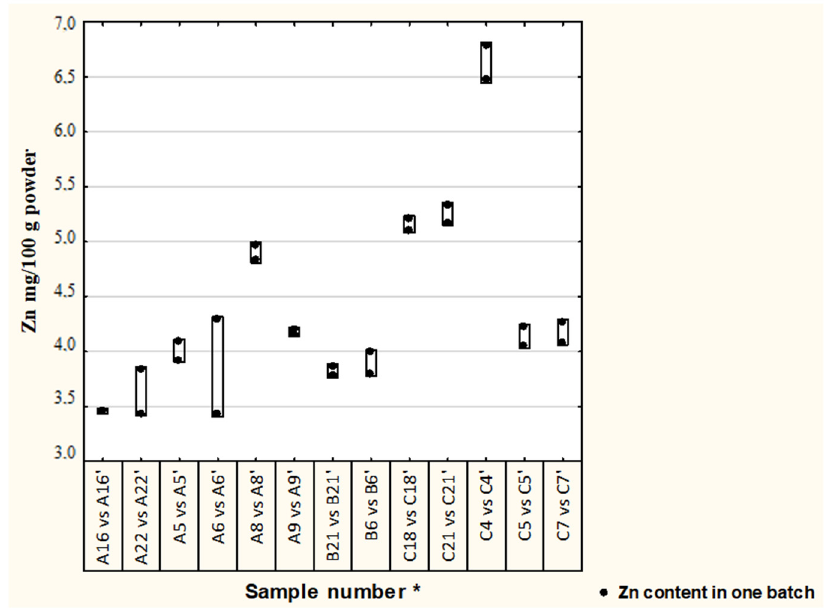
Figure 2. Differences in Zn concentration between batches of analyzed formulae. Second batch of the same formula, * randomly assigned formulae symbols from two other batches According to the nutritional requirements, the adequate intake (AI) of Cu is 0.20